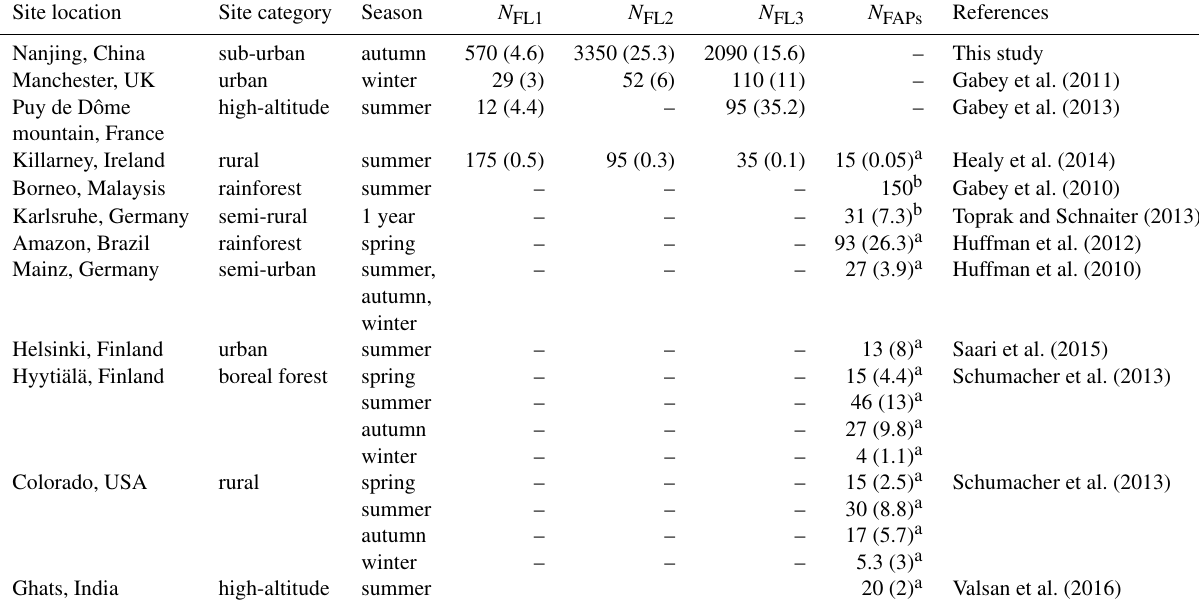
Table 2. Comparisons between the results of this study and previous studies. Unit for the number concentration of fluorescent particles is L − 1 . Numbers in parentheses are the number fractions of fluorescent particles